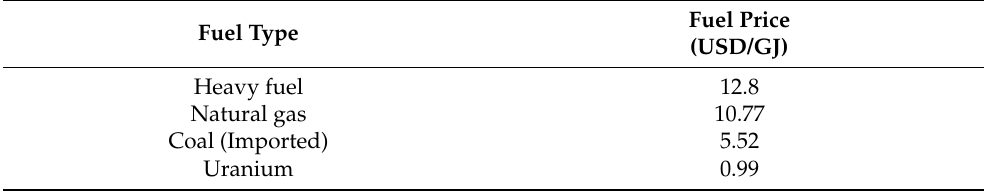
Table 10. The used fuel costs parameters in